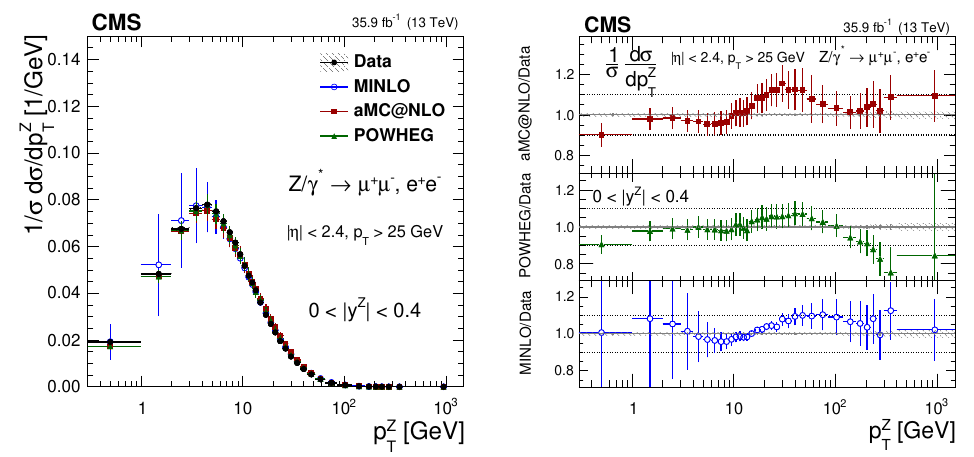
Figure 15 . The measured normalized cross sections (left) in bins of p Z region. The ratios of the predictions to the data are also shown (right). The shaded bands around the data points (black) correspond to the total experimental uncertainty. The measurement is compared to the predictions with MadGraph 5 a mc@nlo (square red markers), powheg (green triangles), and powheg - MINLO (blue circles). The error bands around the predictions correspond to the combined statistical, PDF, and scale uncertainties.